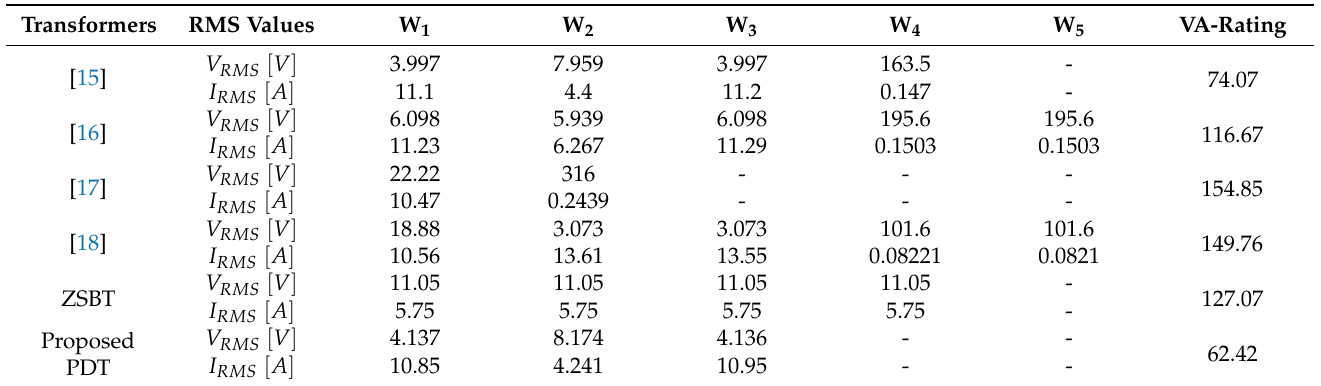
Table 1. RMS values of the voltage and current of different PDTs and their VA-ratings for a 10-kVA